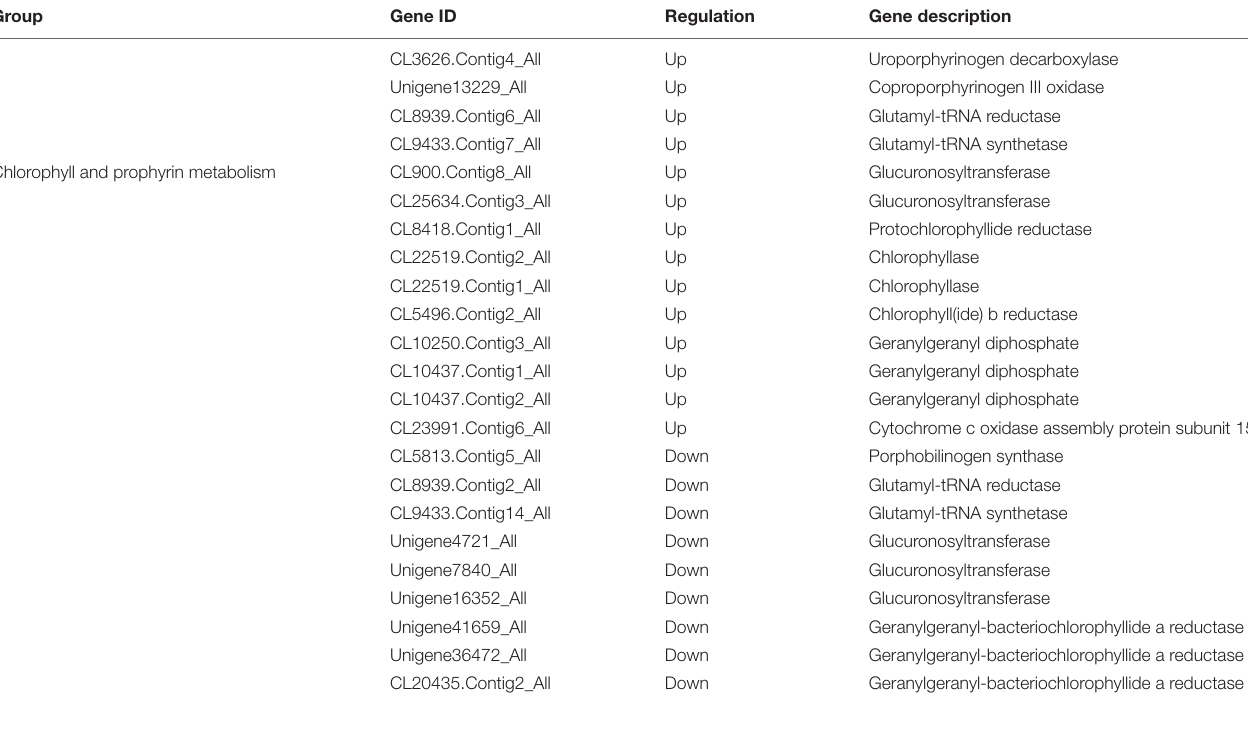
TABLE 3 | DEGs associated with pigment metabolism.